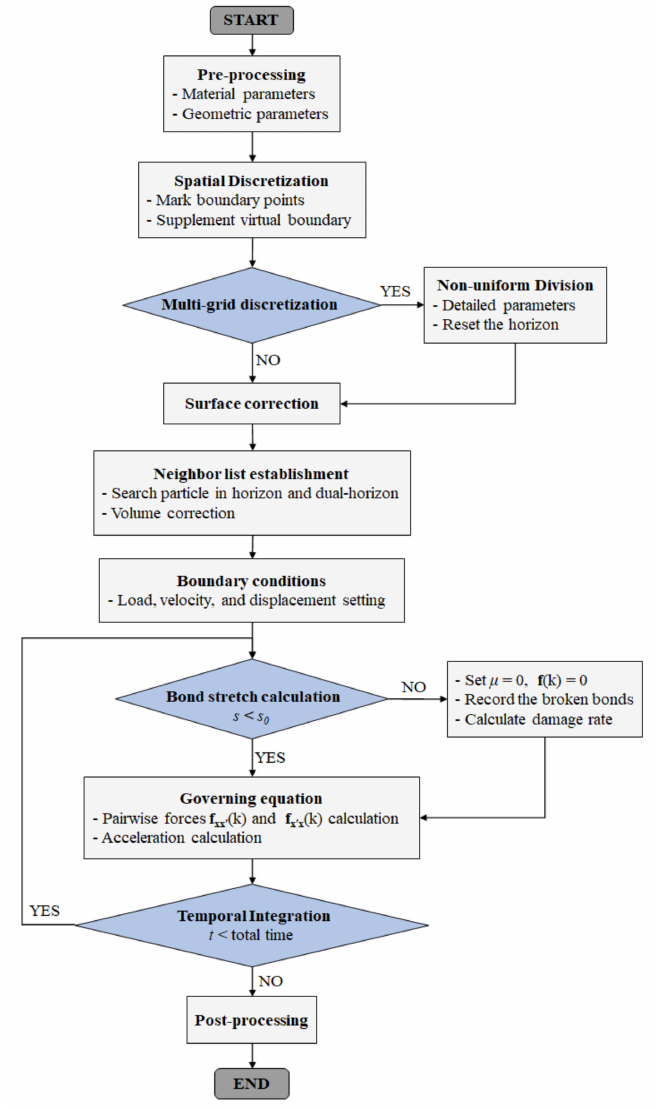
Figure 3. Program flowchart of the DH-PD